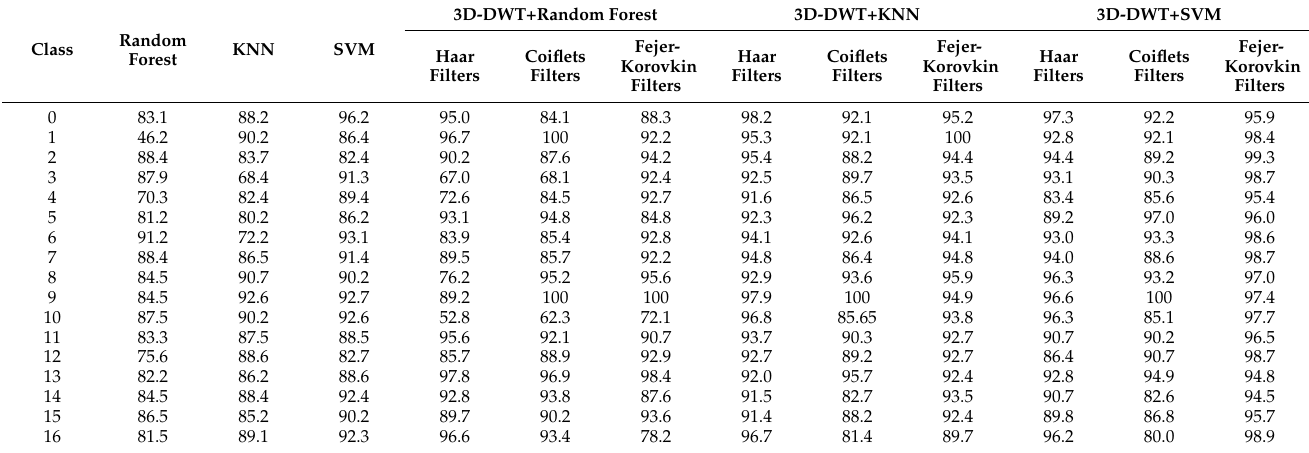
Figure 10. Classification output maps obtained by all computing methods on Salinas Scene hyperspectral data (OAs are described in parentheses). Table 5. Classification accuracy of all the computing methods in Salinas Scene hyperspectral data.